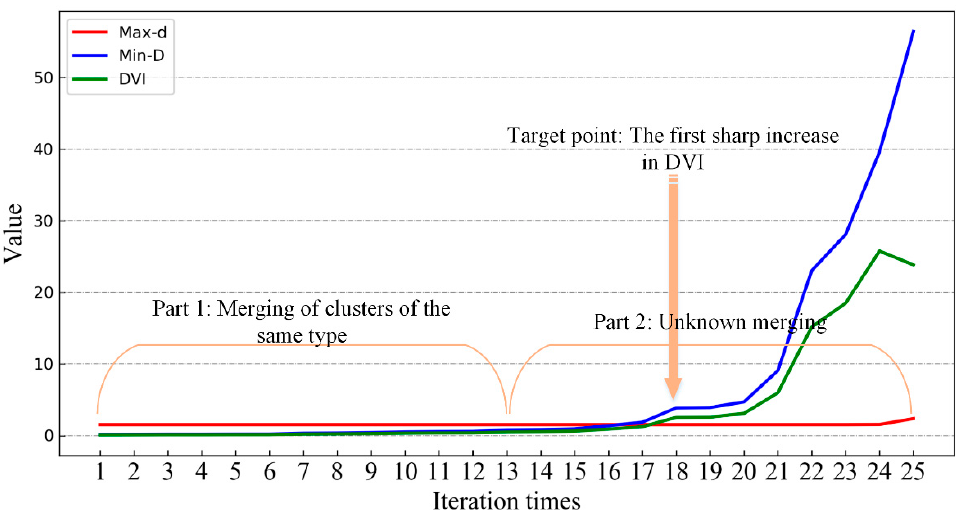
Figure 3. The curve of DVI change with merging times. The green line is the DVI, the blue line is the min distance between classes, and the red line is the max intra-class distance. min distance between classes, and the red line is the max intra-class